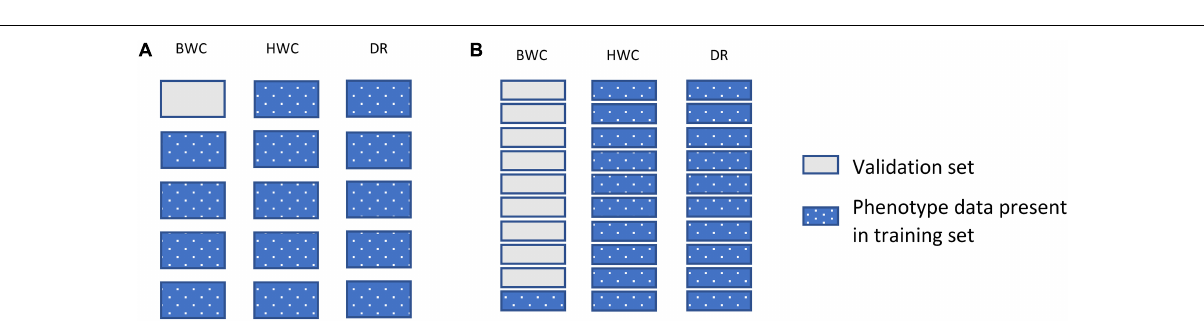
result presented here is the average of the 10 runs. All single- and